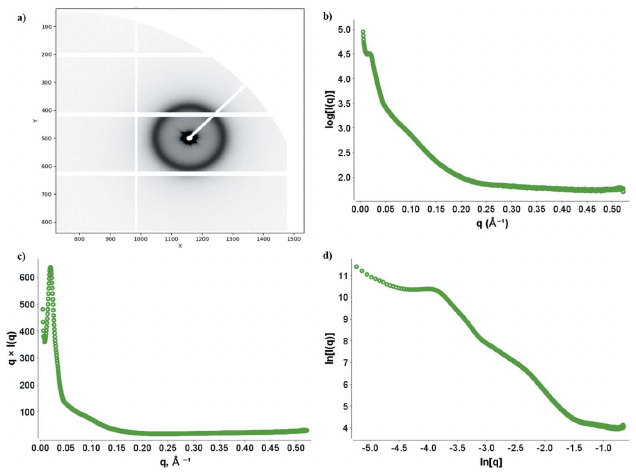
Figure 10 Scattering of gel forming protein, GFP-Elf3-Q0. ( a ) Image of the Pilatus3 X 2M detector showing halo of scattering intensity. ( b ) Intensity ( I ) versus scattering vector ( q ) for GFP-Elf3-Q0 showing a structure factor peak present. ( c ) By multiplying the y -axis by q , a total intensity plot is created emphasizing the structure factor peak. ( d ) A log-intensity plot; the rising Guinier region is indicative of a heterogenous